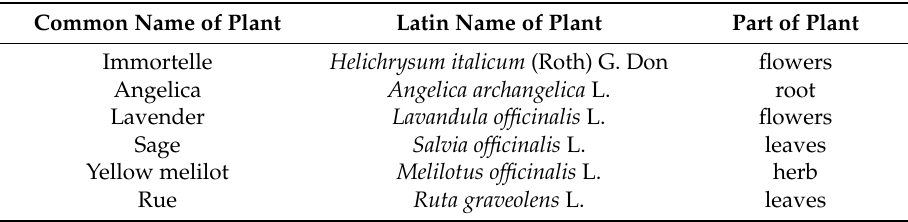
Table 5. The characteristics of medicinal plants used in this